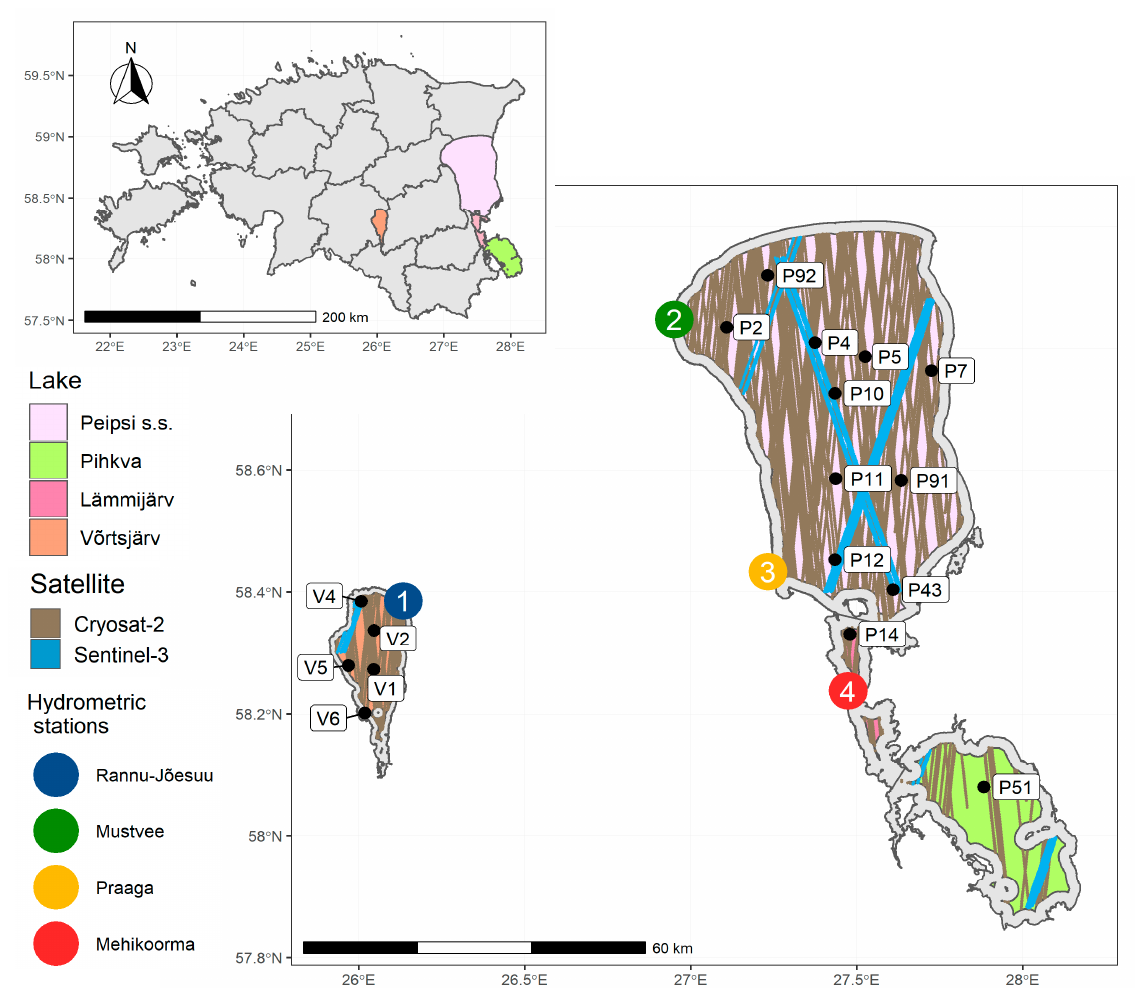
Figure 1. Locations of in situ stations in Võrtsjärv (Vx) and Peipsi (Px). Peipsi consists of three parts: Peipsi s.s. (light purple), Lämmijärv (pink), Pihkva (light green); Võrtsjärv is colored as orange. Buffers of 1 and 2 km from the shore are created for Võrtsjärv and Peipsi respectively. Sentinel-3- altimetry tracks are shown in light blue, whereas Cryosat-2 tracks are shown in brown. Locations of hydrometric stations are numbered as 1 Rannu-Jõesuu (blue), 2 Mustvee (green), 3 Praaga (yellow), 4 Mehikoorma (red). Table 1. Thresholds for chlorophyll a (chl a) (mg/m 3 ), phytoplankton biomass (FBM) (g/m 3 ) and Secchi disk depth (SDD) (m) estimating ecological status class in V õ rtsjärv and Peipsi according to Estonian regulation of Water Act [64]. Each color represents ecological status class defined by Water Framework Directive (WFD) [5] and the range of measured values for each parameter during the study period from both lakes are shown in the last column, whereas the number in the brackets indicates average of the measured values. Very Good